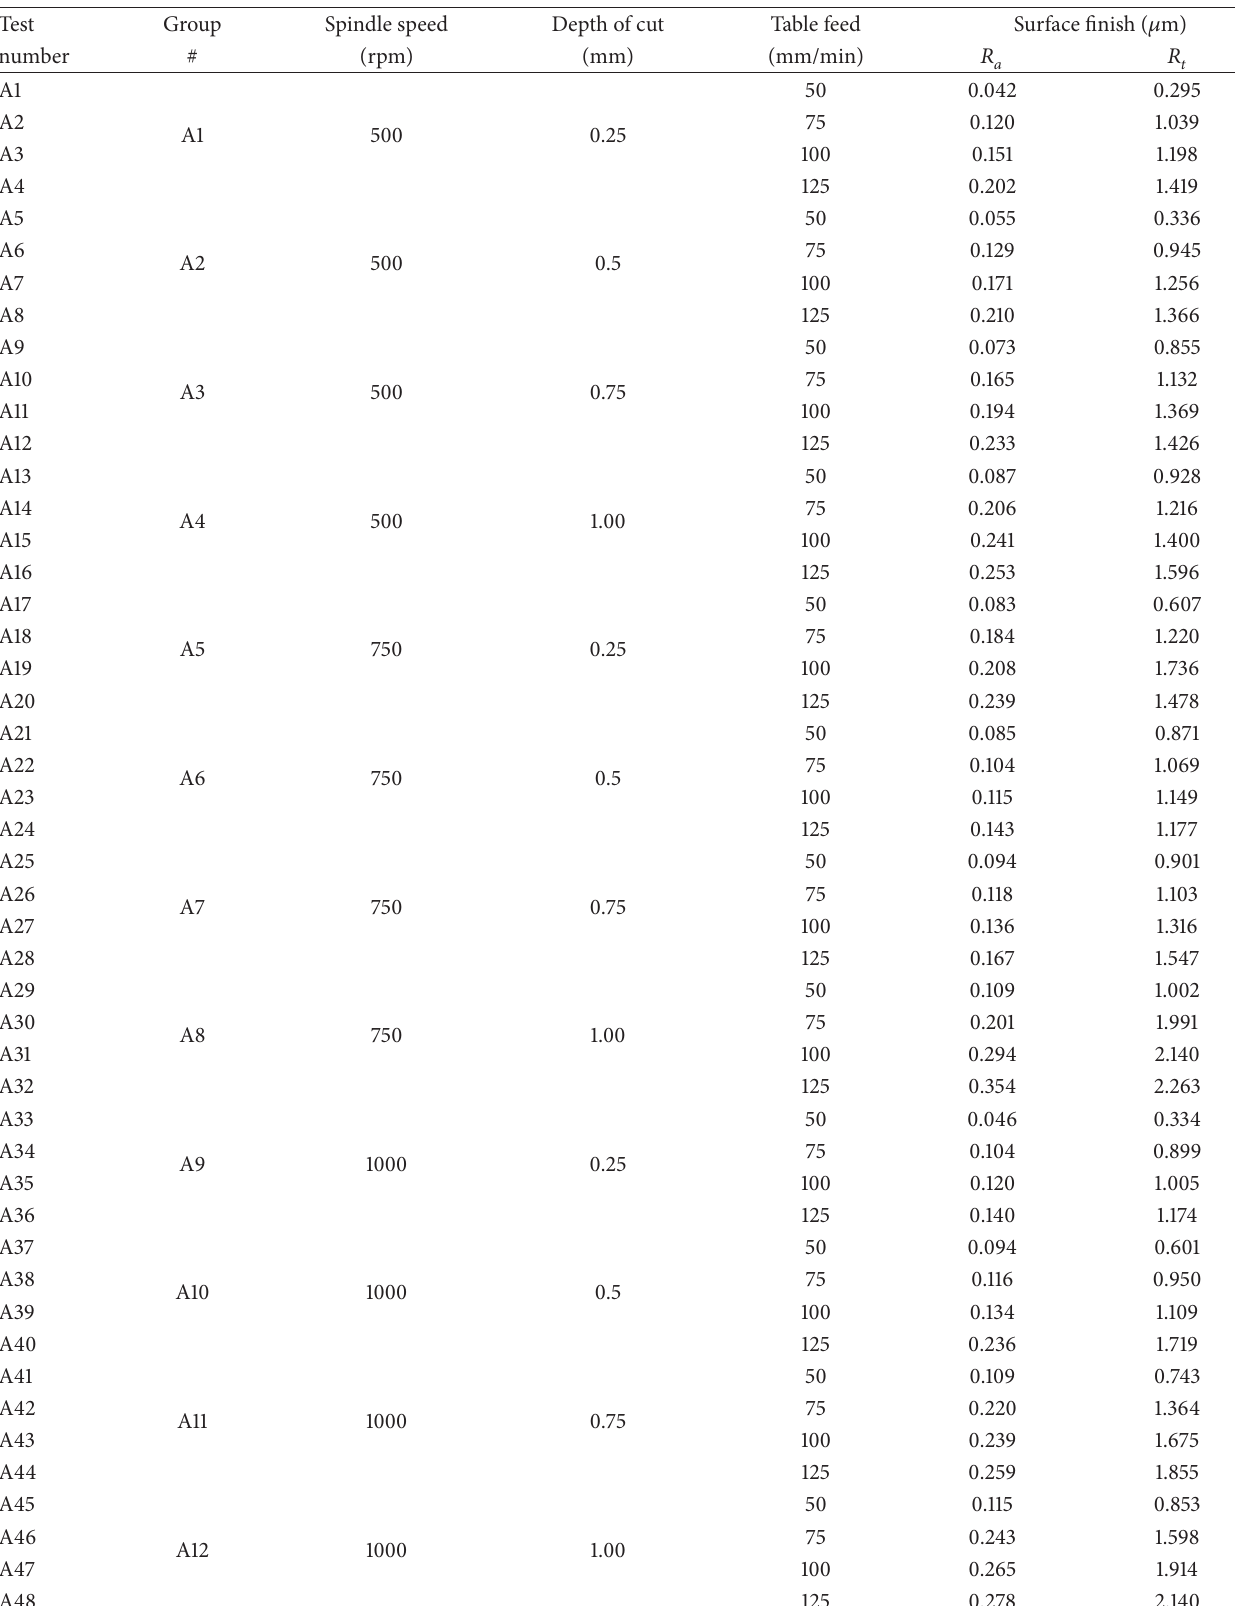
Table 6: Cutting conditions for group